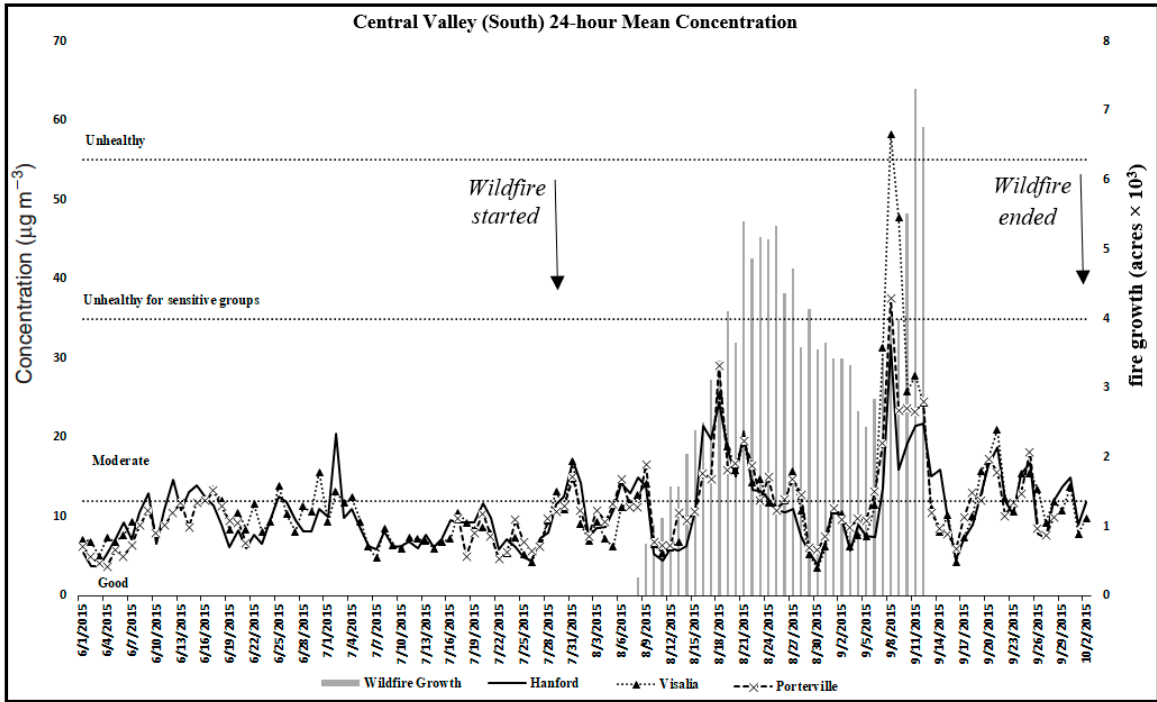
Figure 3. 24-Hour PM 2.5 concentrations with Air Quality Index (AQI) breakpoints for monitoring sites. Note: no daily fire growth data were available at the beginning of the fire.